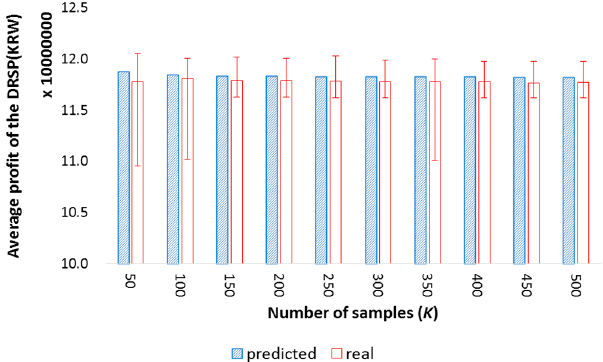
Figure 7. Average profit of the proposed method with different numbers of samples. The stop condition is fixed to 2%. A larger number of samples tend to provide more stable results. KRW refers to the currency of Korea (Korean Won).